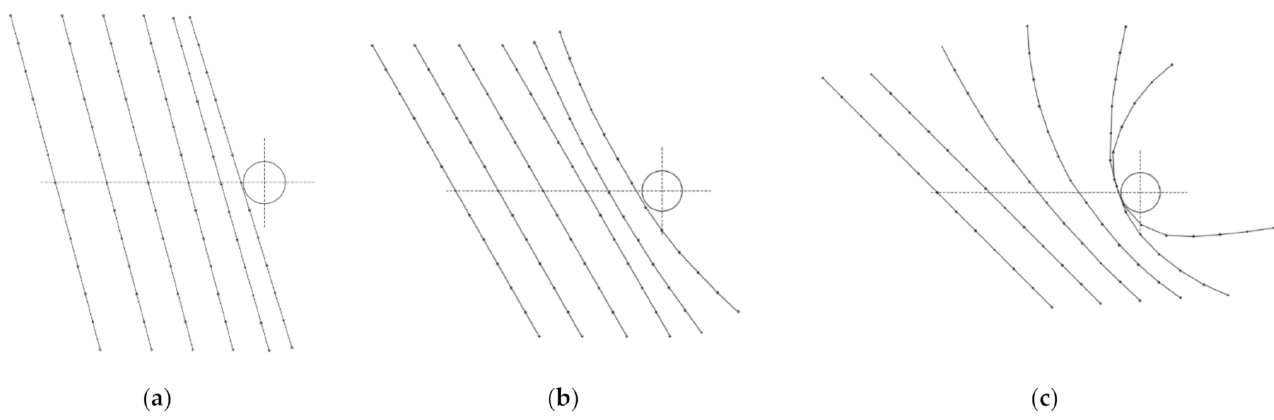
Figure 11. Movement of a single fibre past a cylinder where the ratio of the fibre length to the cylinder diameter is 8: . ∗ = γ ( a ) 1.3 × 10 − 4 , θ = 15 ◦ , ( b )